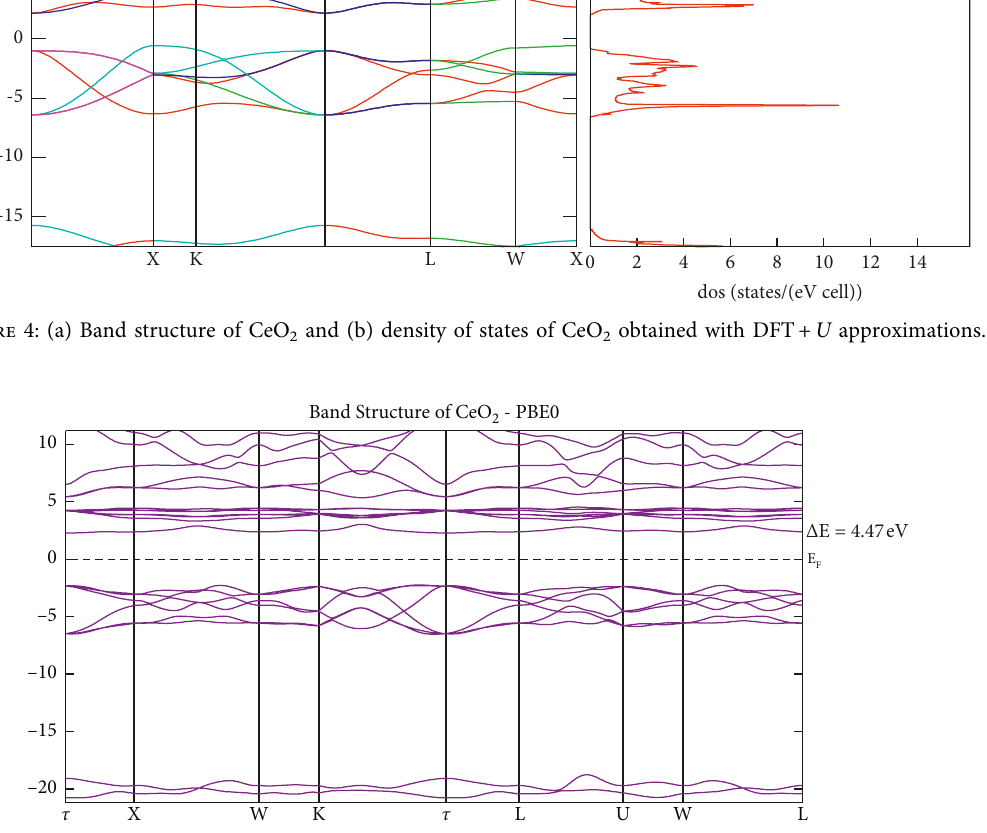
Figure 5: Band structure of CeO 2 obtained with PBE0 approximations.